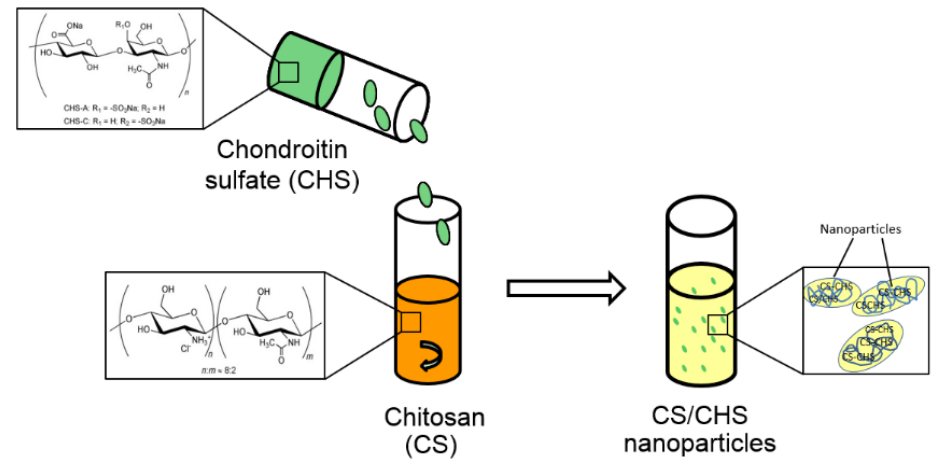
Figure 1. Representative scheme of the formation of CS/CHS nanoparticles by polyelectrolyte complexation.